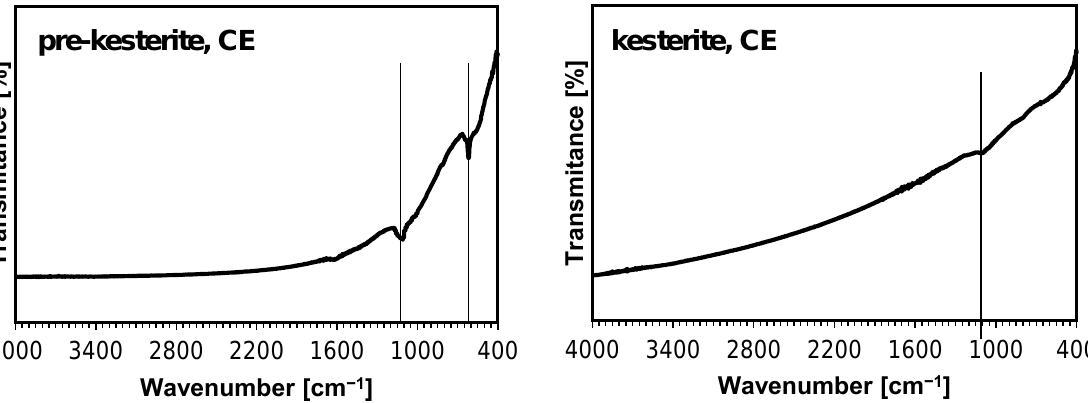
Figure 4. FT-IR spectra for nanopowders from the CE system. Vertical lines show the positions of the bands typical for various metal sulfates.